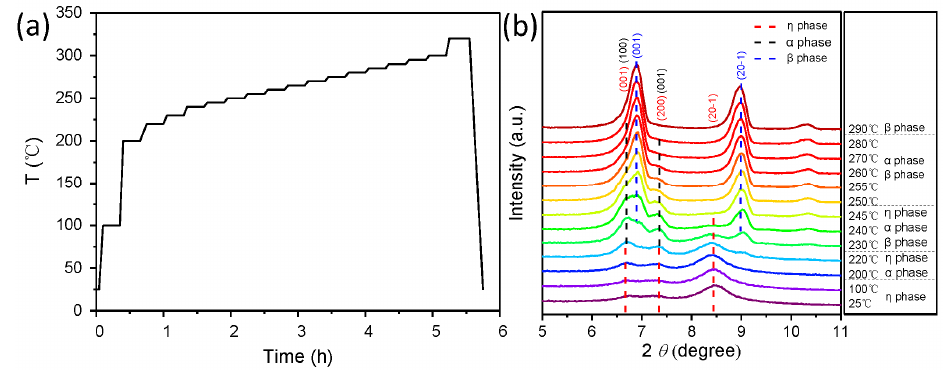
Figure 2. ( a ) The heating process of the sample during the In-situ XRD measurement. ( b ) The in situ XRD patterns of CuPc crystals as a function of temperature with the panel on the right show the phase type at different temperature regions.